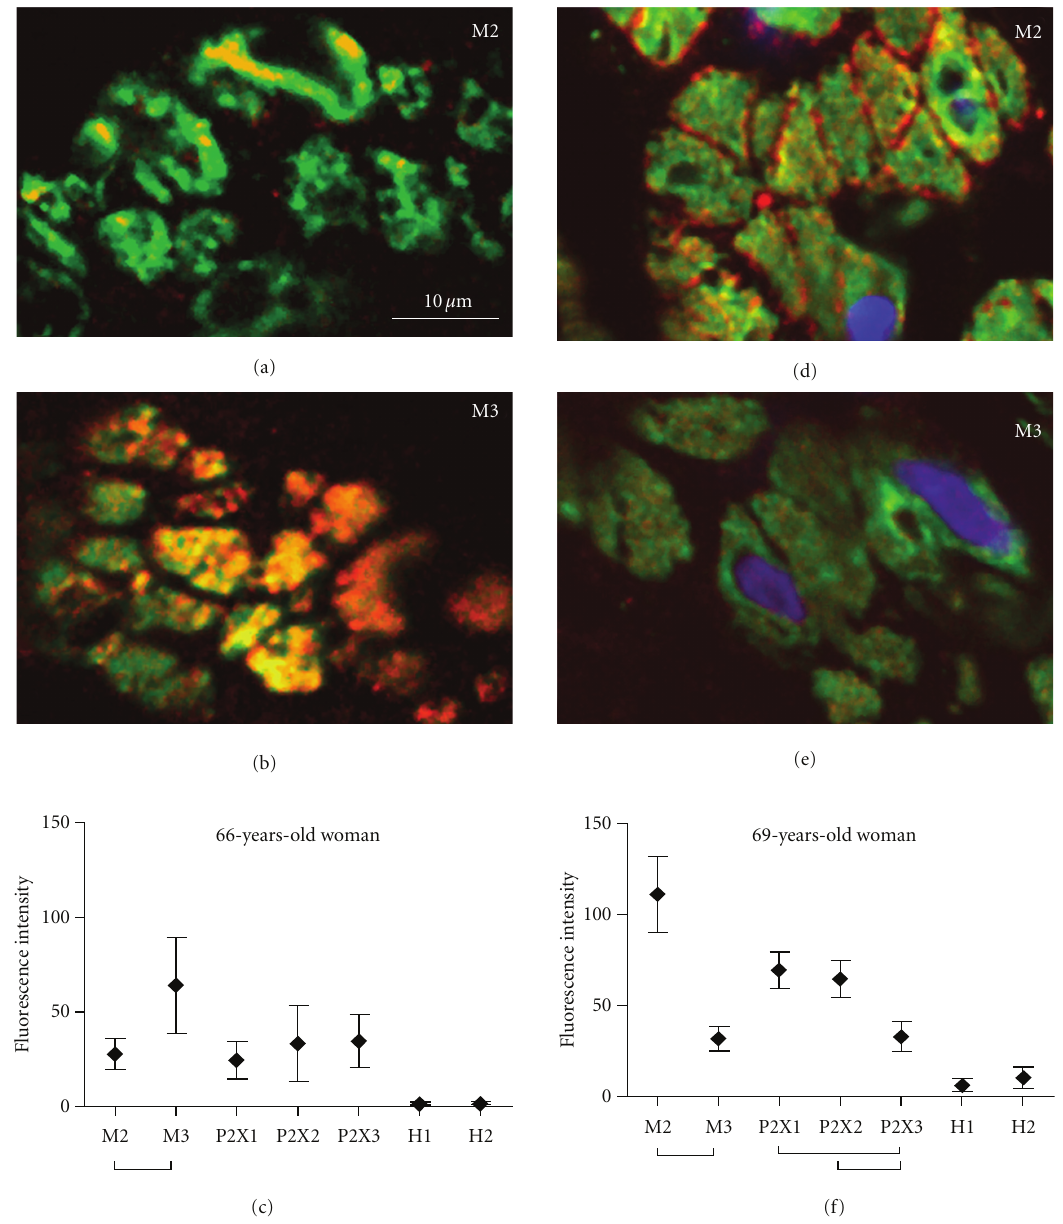
Figure 3: Examples of individual receptor expression profiles based on confocal immunofluorescence analysis. (a–c) showing a female patient with overexpression of M3, P2X1-3 receptors; (d–f) typical distribution in IC patients with overexpression of M2 receptor; in addition, this patient shows high levels of purinergic receptors and significant expression of histamine H2 receptor; aSMCA (green); receptor staining (red); nuclear staining (blue); bar in (a) applies to all micrographs; (c, f) mean ± SD; bars indicate significant di ff erences (ANOVA, Tukey’s Test, P < 0 .